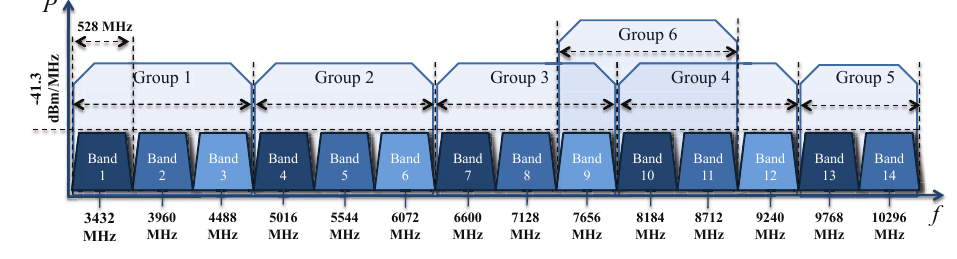
Figure 1. The ECMA-368 band